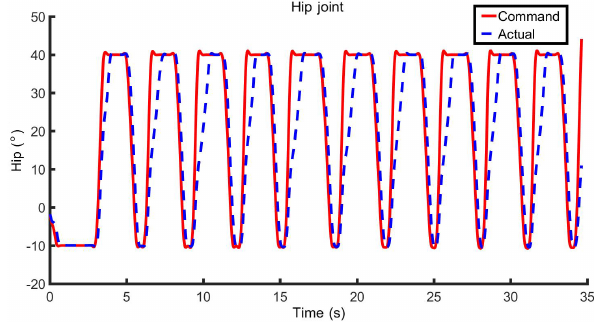
Figure 14. Relationship between the PEM signal and the command signal for the hip joint.